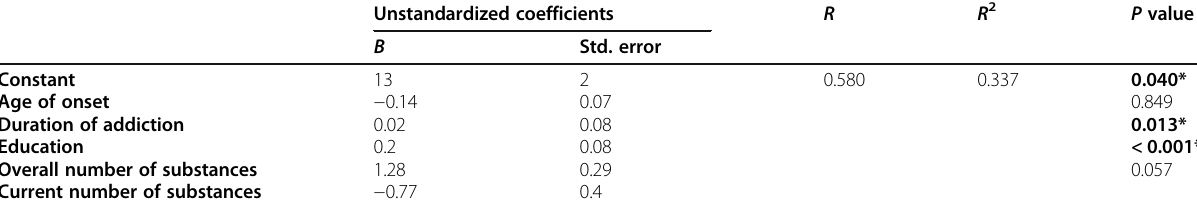
Table 6 Multiple linear regression analysis to detect the predictors affecting Addiction Intensity Scale (AIS) scoring